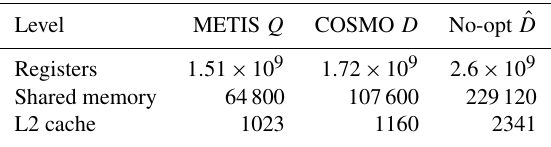
Table 3. Performance model verification results. Measured dynam- ical core time step execution time for the STELLA implementation optimized for data locality and the non-optimized implementation compared against the corresponding MUE